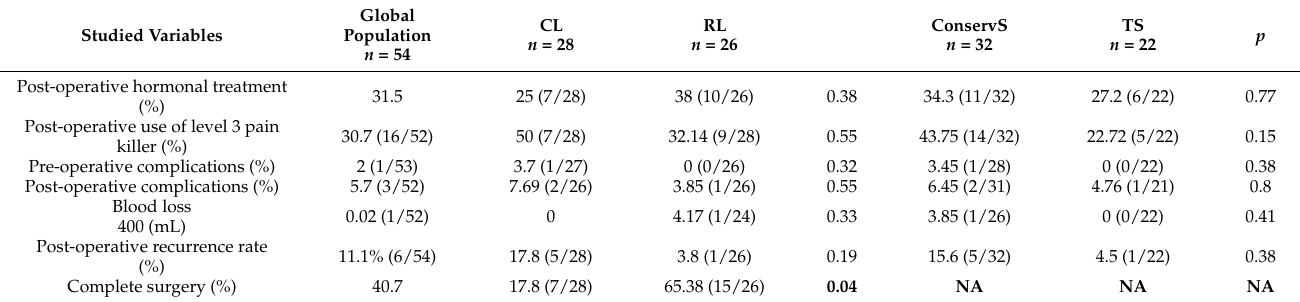
Table 2. Secondary outcomes and post-operative description for global population, robotic la- paroscopy (RL), classical laparoscopy (CL), total surgery (TS), and conservative surgery